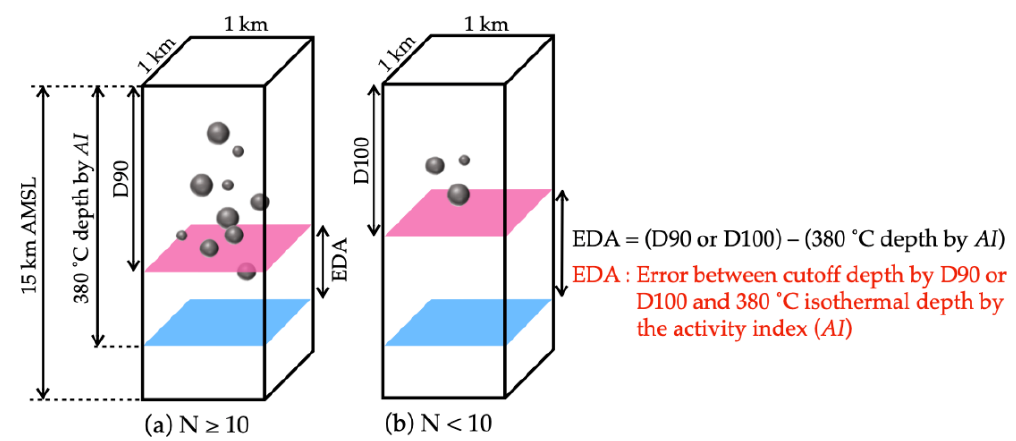
Figure 6. Schematic diagram showing determination of the bottom of seismogenic zone. ( a ) If more than 10 earthquakes occurred in a column, D90 was considered; ( b ) if less than 10 earthquakes occurred in a column, D100 was considered.